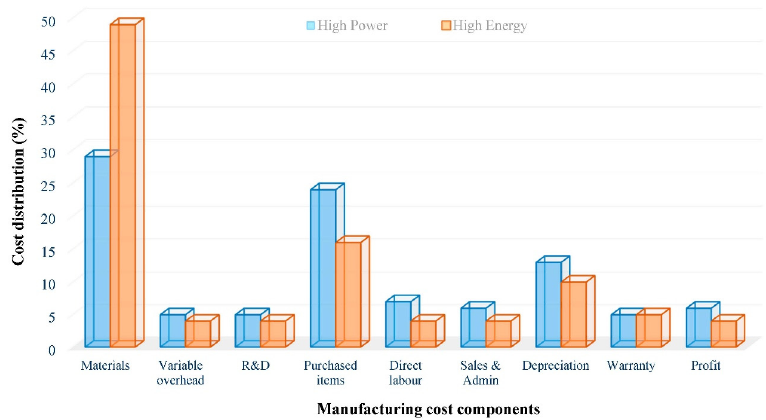
Figure 5. Comparison of overall manufacturing costs distribution (excluding pack integration system) for a high power and a high energy battery packs (based on data available from [57]).